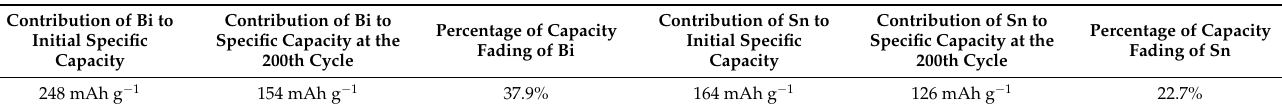
Table 5. Performances of Mg cells assembled with NP-Bi 6 Sn 4 anode, with a focus on the contribution of each metal at different stages of the charge/discharge